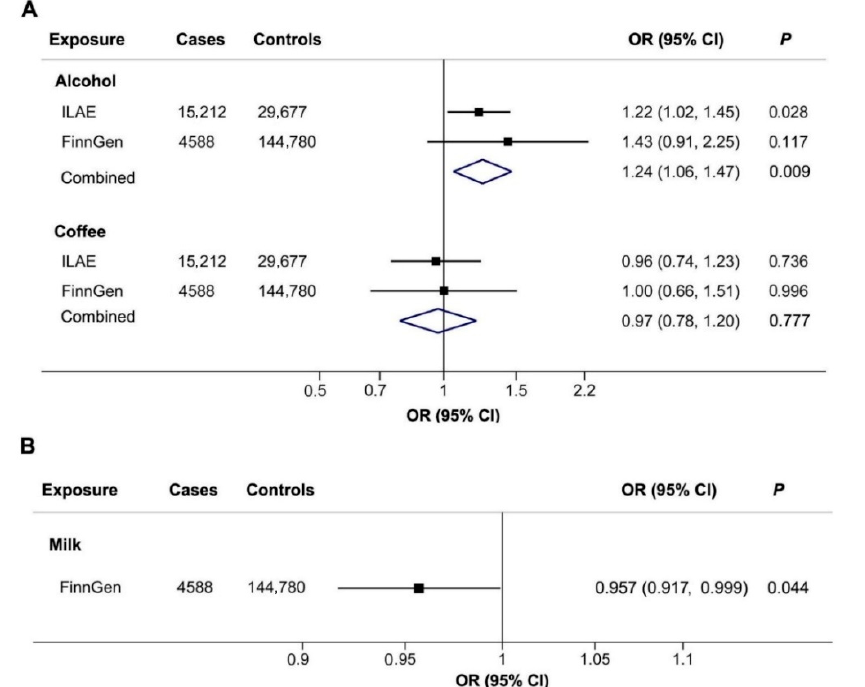
Figure 1. Associations of genetically predicted alcohol intake with epilepsy in the International League Against Epilepsy (ILAE) and FinnGen consortiums.